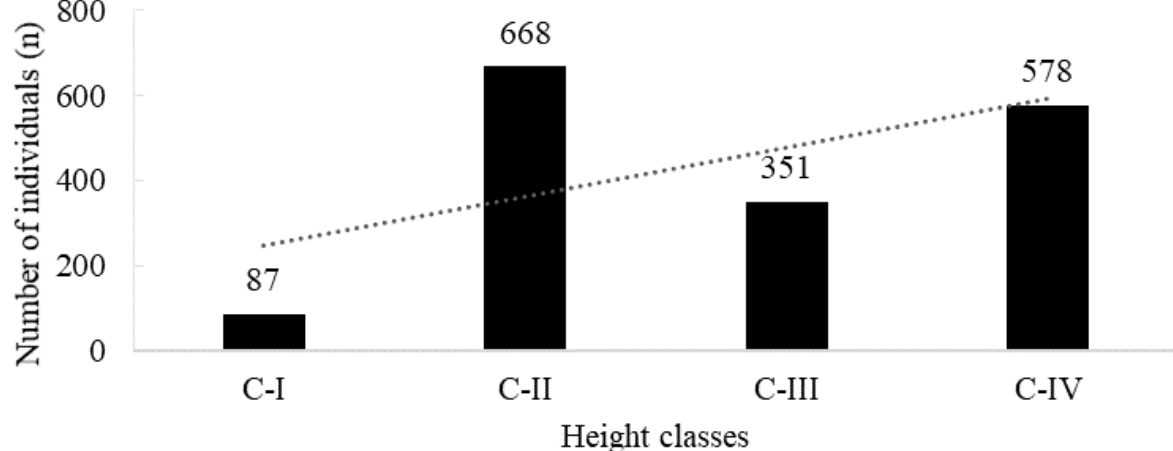
Figure 3. Number of individuals of tucumã-do-pará by height class in the physiognomies of Backyard (B), Savannah Park (SP), transition between Savannah grassland and Savannah Park (G/SP), Secondary Forest (SF), and Savannah grassland